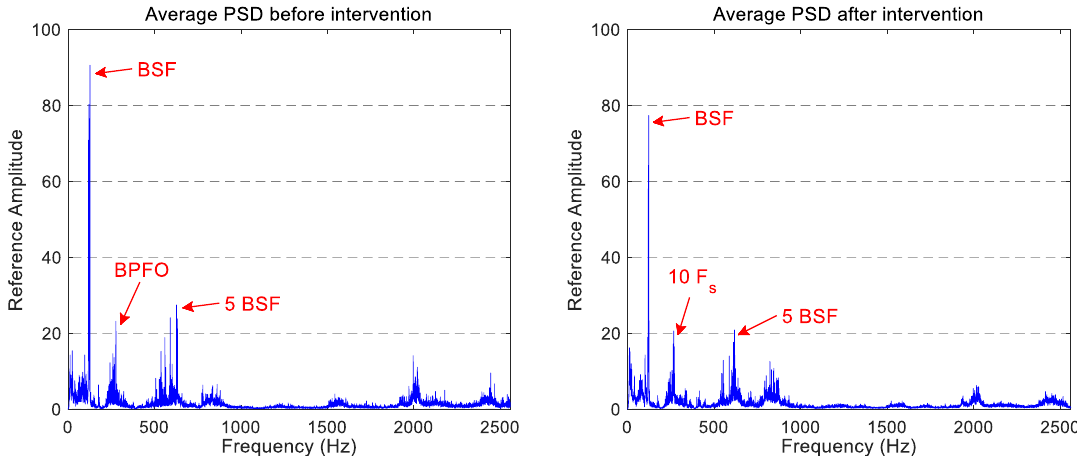
Figure 6. The comparison of the average spectrum for longitudinal accelerations obtained before and after the wheels intervention.